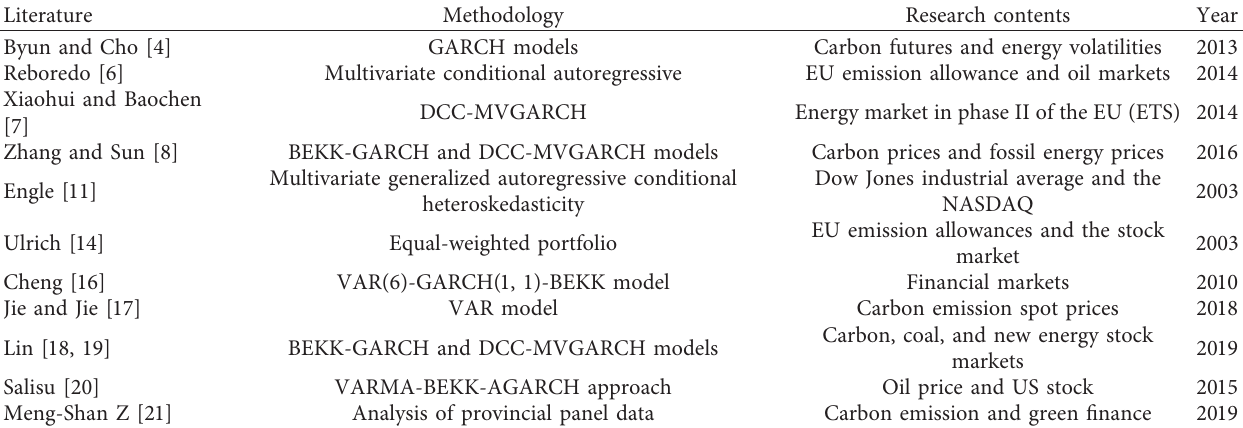
Table 1: Summary of related